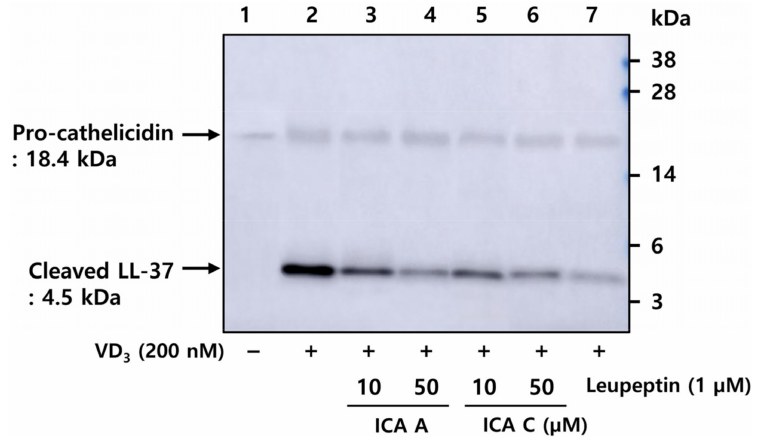
Figure 3. Chlorogenic acid isomers inhibit the proteolytic cleavage of cathelicidin by blocking KLK5 activation. HEKn was pretreated with 10 and 20 µ M isochlorogenic acid A and isochlorogenic acid C, respectively, followed by 1 µ M leupeptin, a serine protease inhibitor, for 1 h, and subsequently treated with 200 nM VD 3 for 48 h. HEKn culture media were collected and subjected to Western Blot analysis with anti-LL-37 antibody. Lane 1, DMSO vehicle control; lane 2, HEKn + VD 3 ; lanes 3 and 4, HEKn + VD 3 + 10, 50 µ M isochlorogenic acid A; lane 5 and 6, HEKn + VD 3 + 10, 50 µ M isochlorogenic acid C; lane 7, HEKn + VD 3 + 1 µ M leupeptin. ICA A, isochlorogenic acid A; ICA C, isochlorogenic acid C.